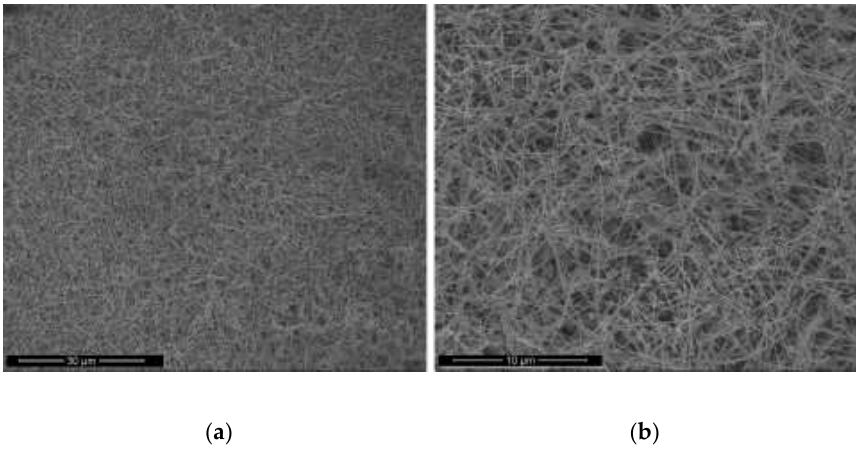
Figure 14. SEM images of copper nanowires with 9 M of NaOH: ( a ) scale bar 30 µm; ( b ) scale bar 10 µm.